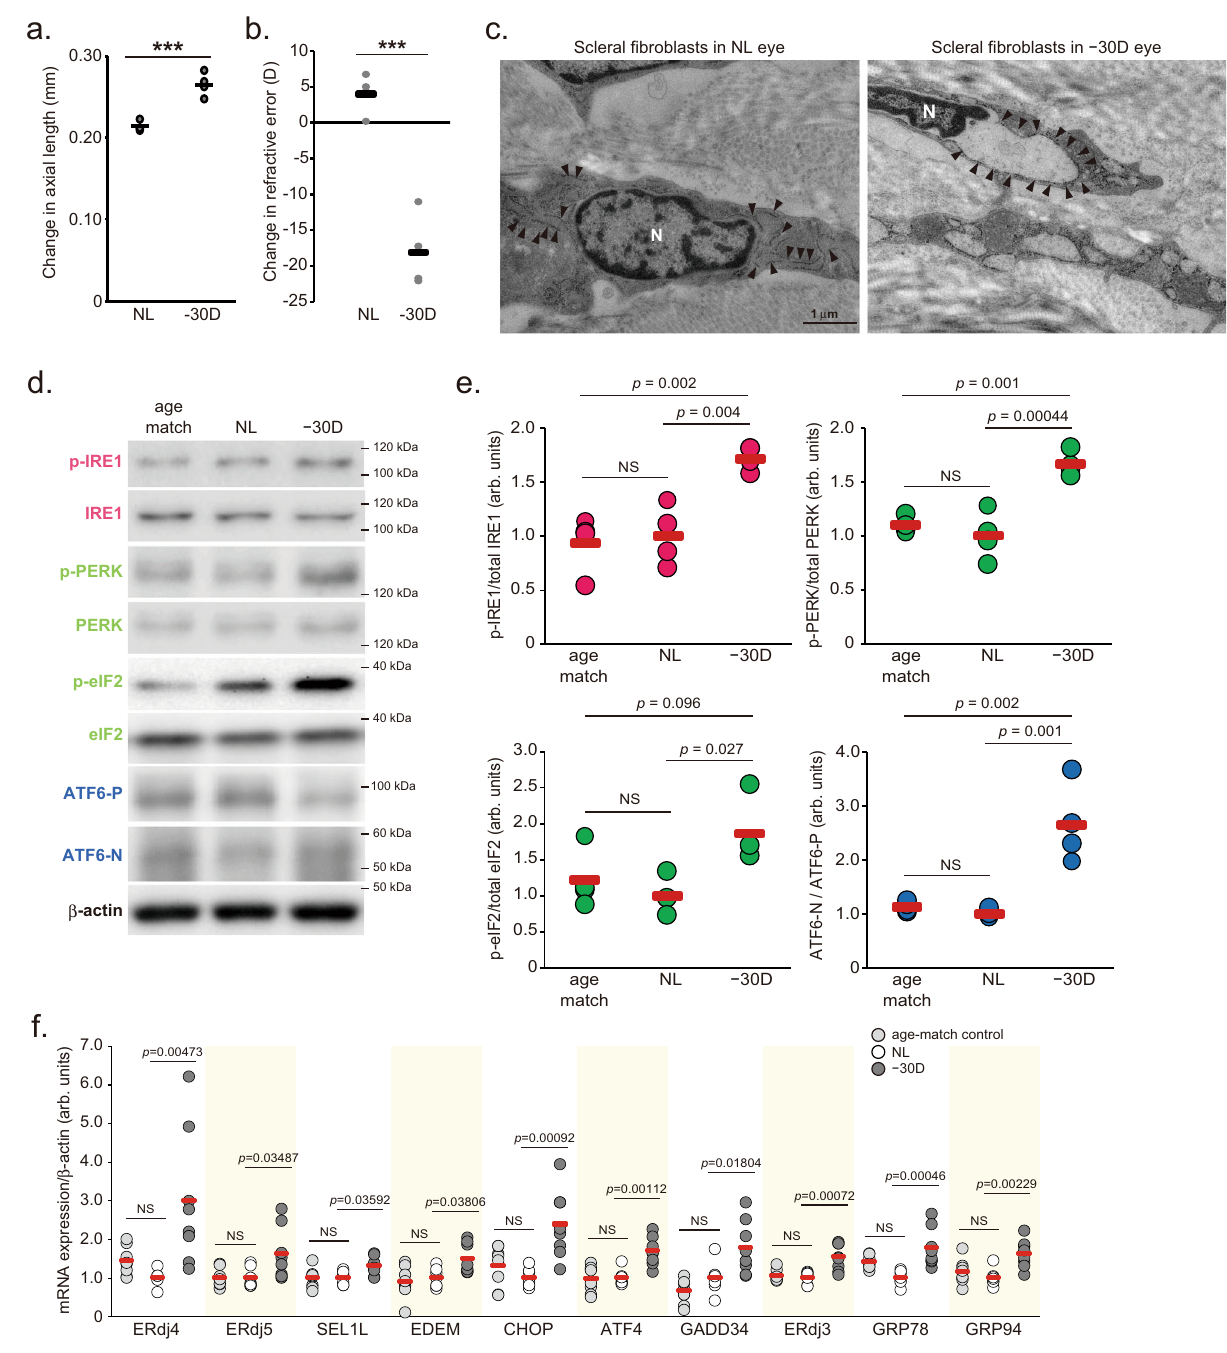
Fig. 1 | Lens-induced myopia induces axial elongation and endoplasmic reti- culum stress in the sclera. a Changes in axial length during 3-week lens-induced myopia(LIM)inC57BL6Jmice( n =4).NL:NoLenscontrol, − 30D:minus30Dlens- wearing eye. *** p =0.00062; Student ’ s two-tailed t -test. b Changes in refraction during 3-week LIM in C57BL6J mice ( n =4); *** p =0.00029; Student ’ s two-tailed t -test. c Transmission electron microscopy images of no lens (NL)-wearing (left panels) and minus 30 D lens-wearing (right panels) sclerae. Representative ima- ges of three biologically independent samples; N indicates nucleus and allow heads indicate rough endoplasmic reticulum. Scale bars: 1.0 µ m. d Immunoblots showingERsensorproteinactivationevaluatedbyphosphorylationlevelsofIRE1, PERK,eIF2 α (downstreamofPERK),andtheATF6precursor(ATF6-P)andcleaved